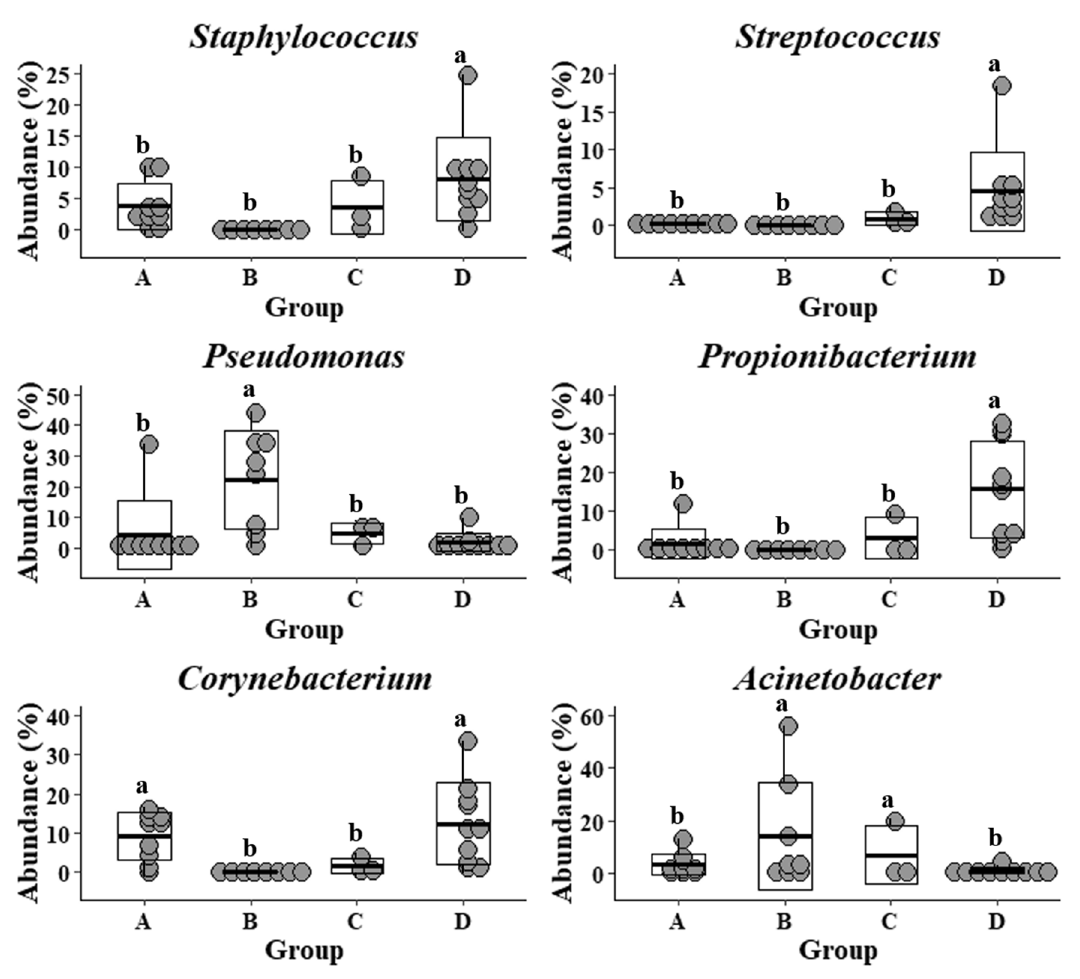
Figure 3. Relative abundance of specific genera in forearm skin microflora. The relative skin microbial abundance of Staphylococcus , Streptococcus , Pseudomonas , Propionibacterium , Corynebacterium , and Acinetobacter in the investigated individuals from the dairy farm in Clarksville ( A ), the integrated farm in Upper Marlboro ( B ) and Washington DC ( C ), and University of Maryland—College Park campus ( D ) was analyzed and compared. Letters a and b indicate significant differences among groups that are based on ANCOM.